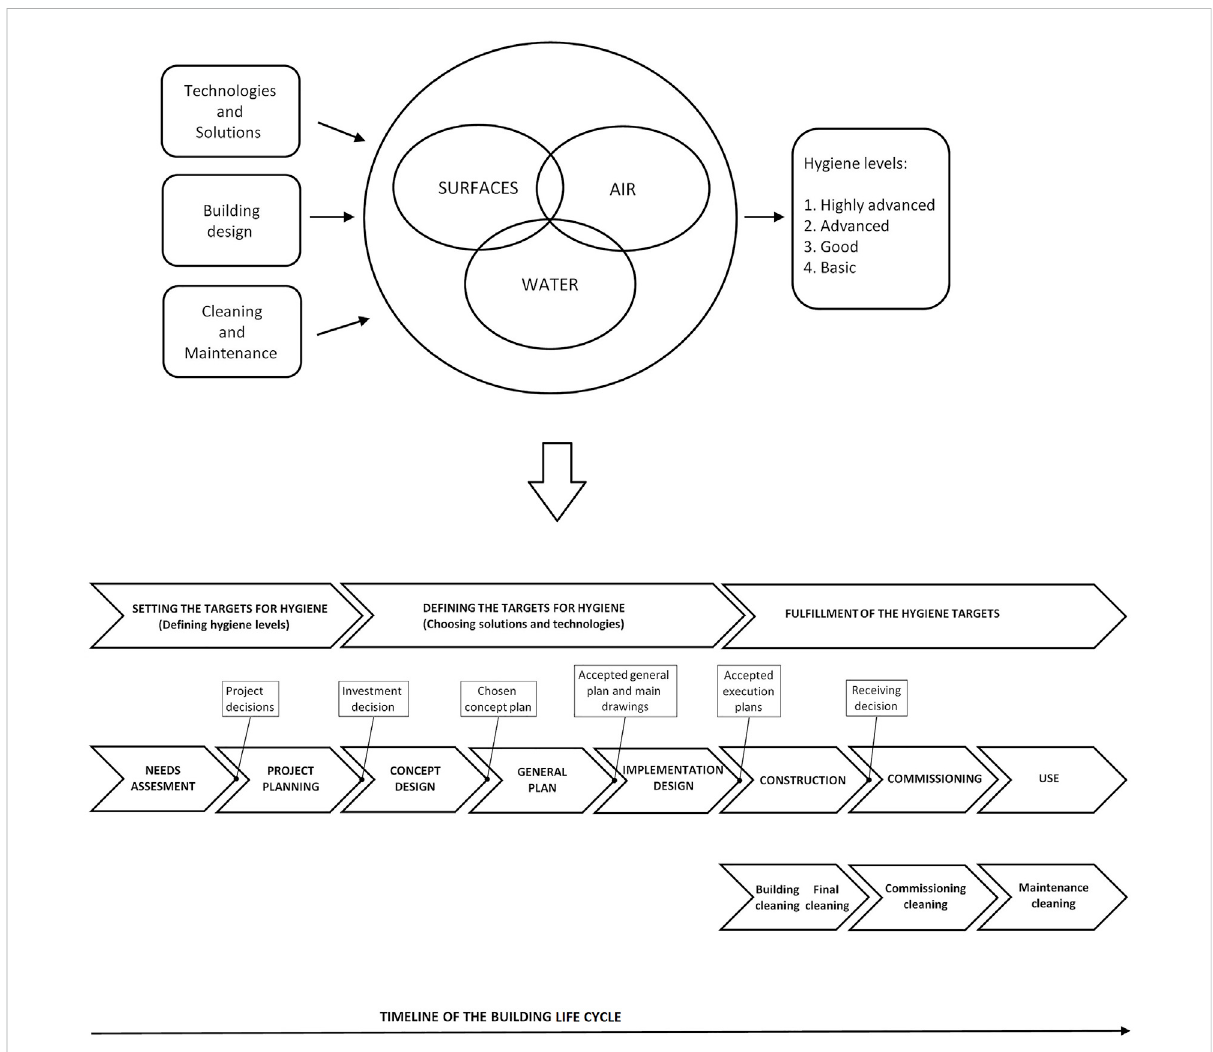
FIGURE 2 The idea of IHC. All the critical components that affect the hygiene of an indoor environment need to be considered to reach the required hygiene level. The IHC should be implemented throughout a building ’ s life cycle. The points of transition between the phases of a construction project are critical for maintaining the targets of the IHC (timeline adapted from Finnish Building Information Foundation RTS sr, 2021b and Finnish Building Information Foundation RTS sr,